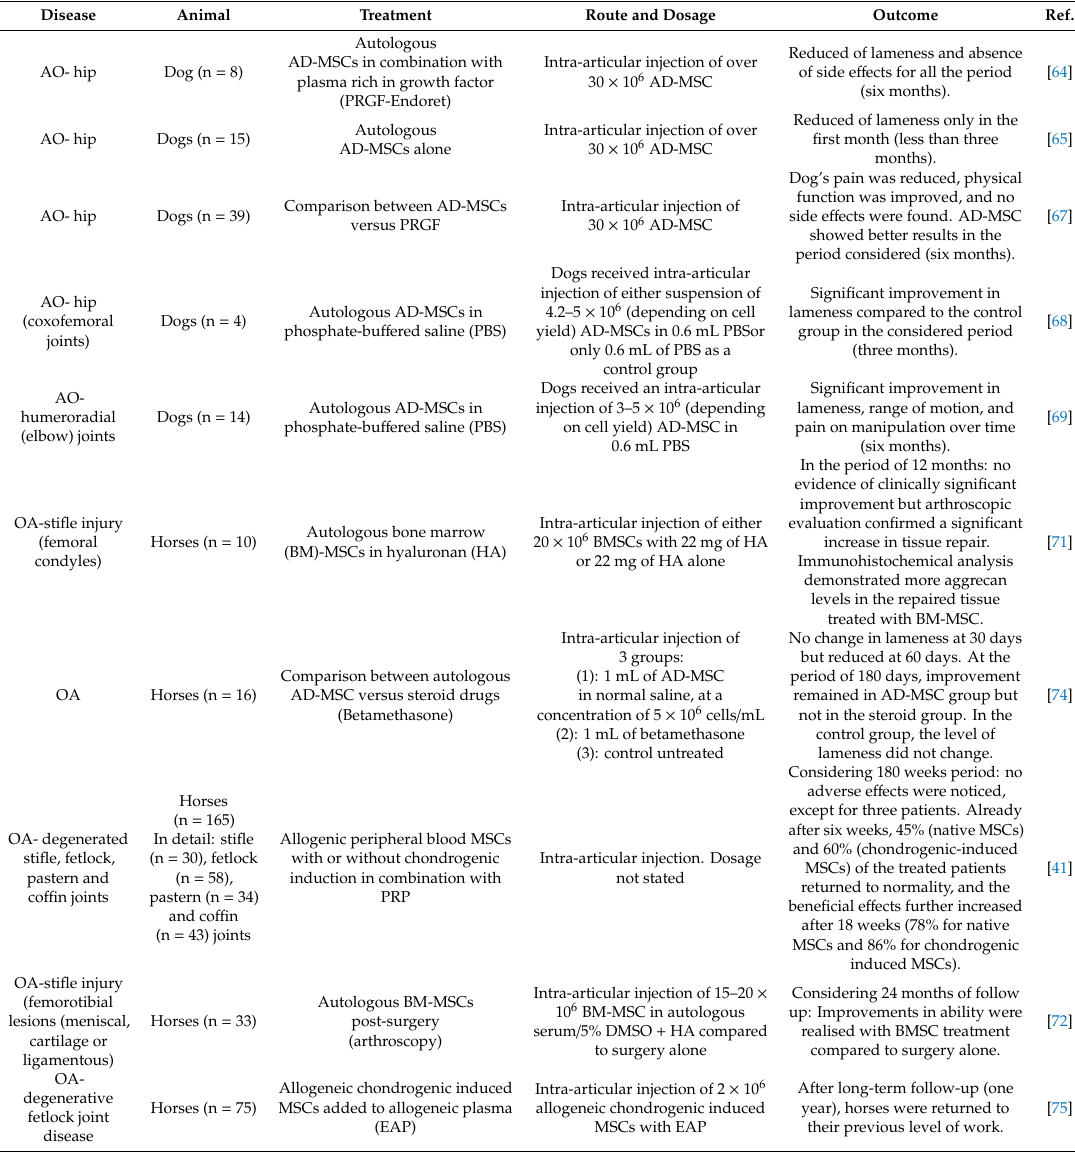
Autologous BM-MSCs post-surgery